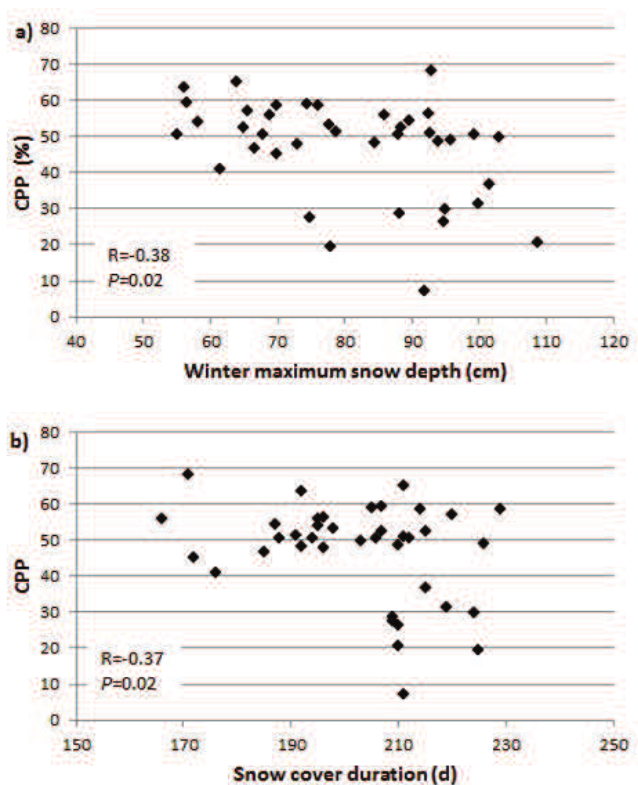
Figure 3. Calf production percentage (CPP) in relation to the annual observed maximum snow depth (a) and duration of the snow cover (b) in the Muonio reindeer herding district during 1972-2010. Pear- son correlation coefficients and P -va lues given in the figures.